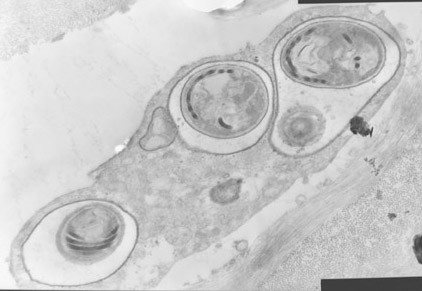
The electron microscopic examination of the corneal button revealing macrophage with three spores.